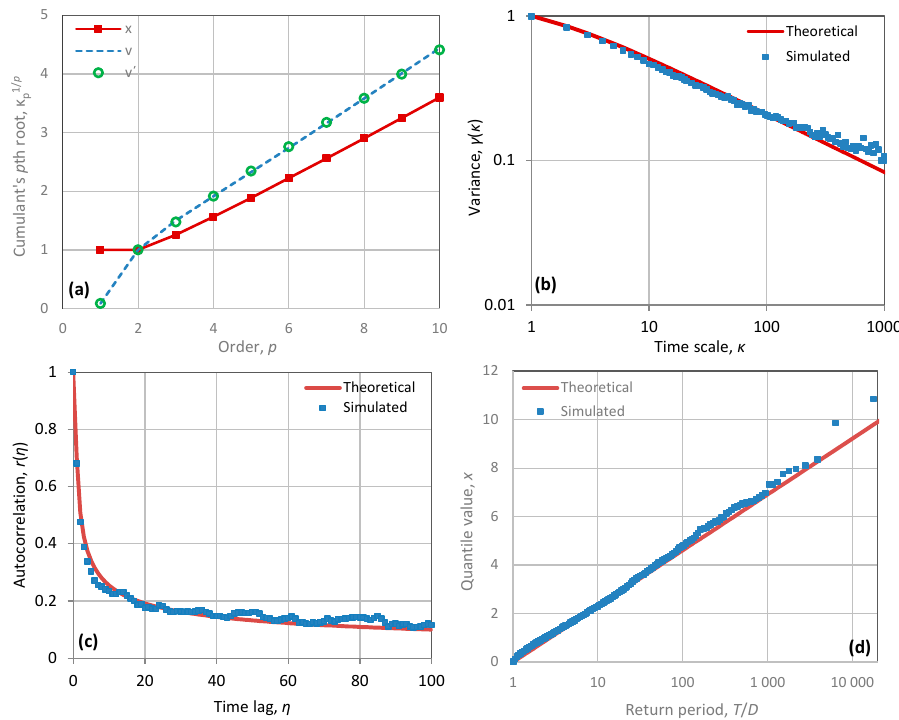
00.20.40.60.81 Figure 1. Graphical depiction of the results of the simulation application for a synthetic example of a persistent FHK process with exponential distribution: ( a ) cumulants; ( b ) climacogram; ( c ) autocorrelogram; ( d ) marginal distribution.